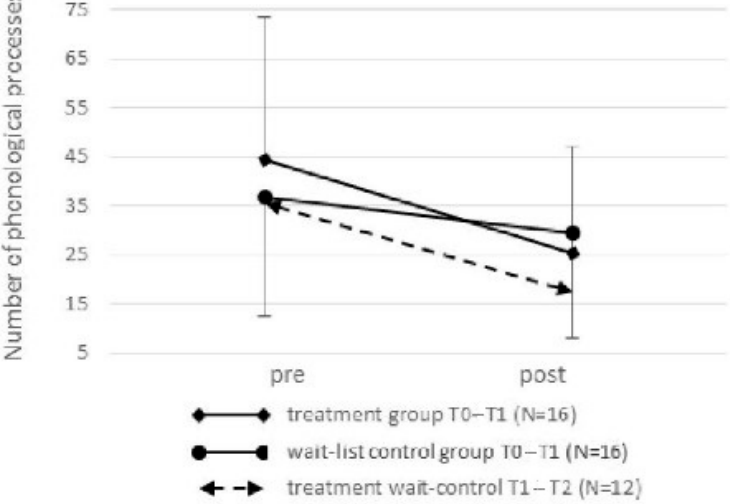
Figure 4. Change in number of phonological processes from To to T1, for the mean of the treatment group and the wait-list control group (solid lines). Change in number of phonological processes from T1 to T2 for the wait-list control group after their treatment phase following the waiting phase is shown as dashed line.